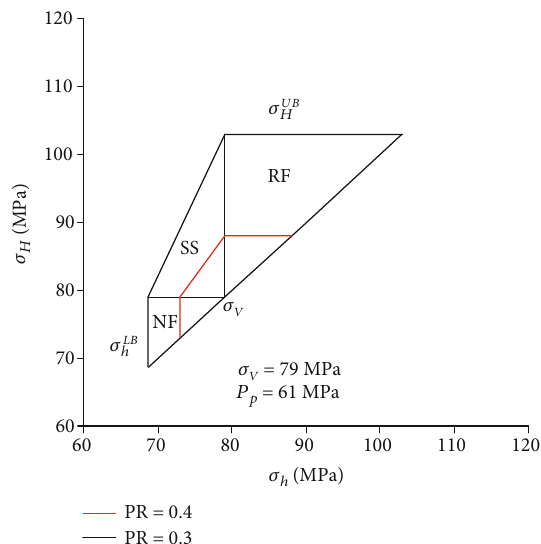
Figure 5: Upper bound and lower bound principal stresses and stress polygons calculated from Eqs. (15) and (16) in two di ff erent Poisson ’ s ratios (PR in the fi gure). In the fi gure, RF, SS, and NF represent the reverse, strike-slip, and normal faulting stress regimes,